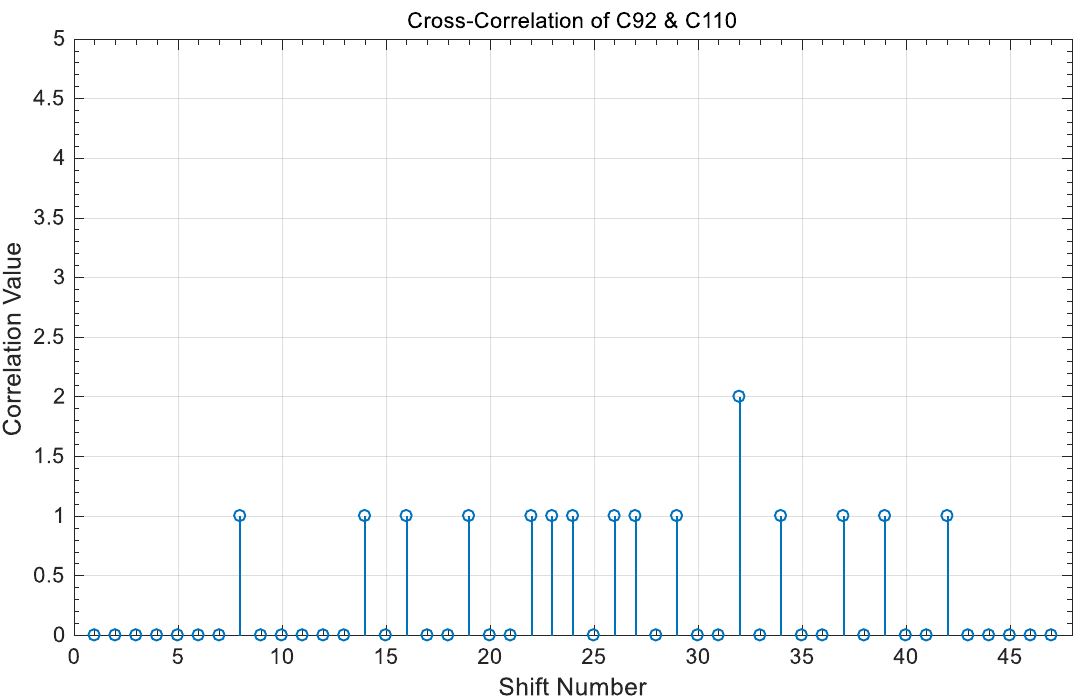
Figure 17. Cross-correlation between 𝐶 92 and 𝐶 110 sequences from different groups, 𝑃 1 = 5 and 𝑃 2 = 7.